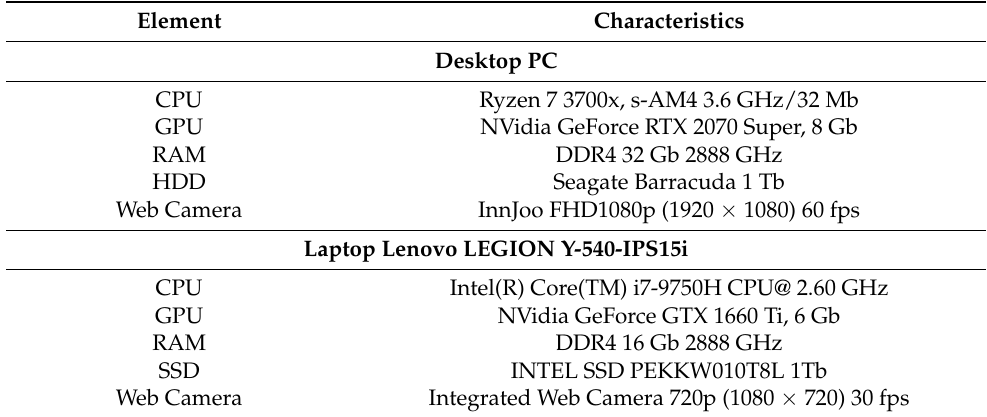
Table 2. Equipment for developing and